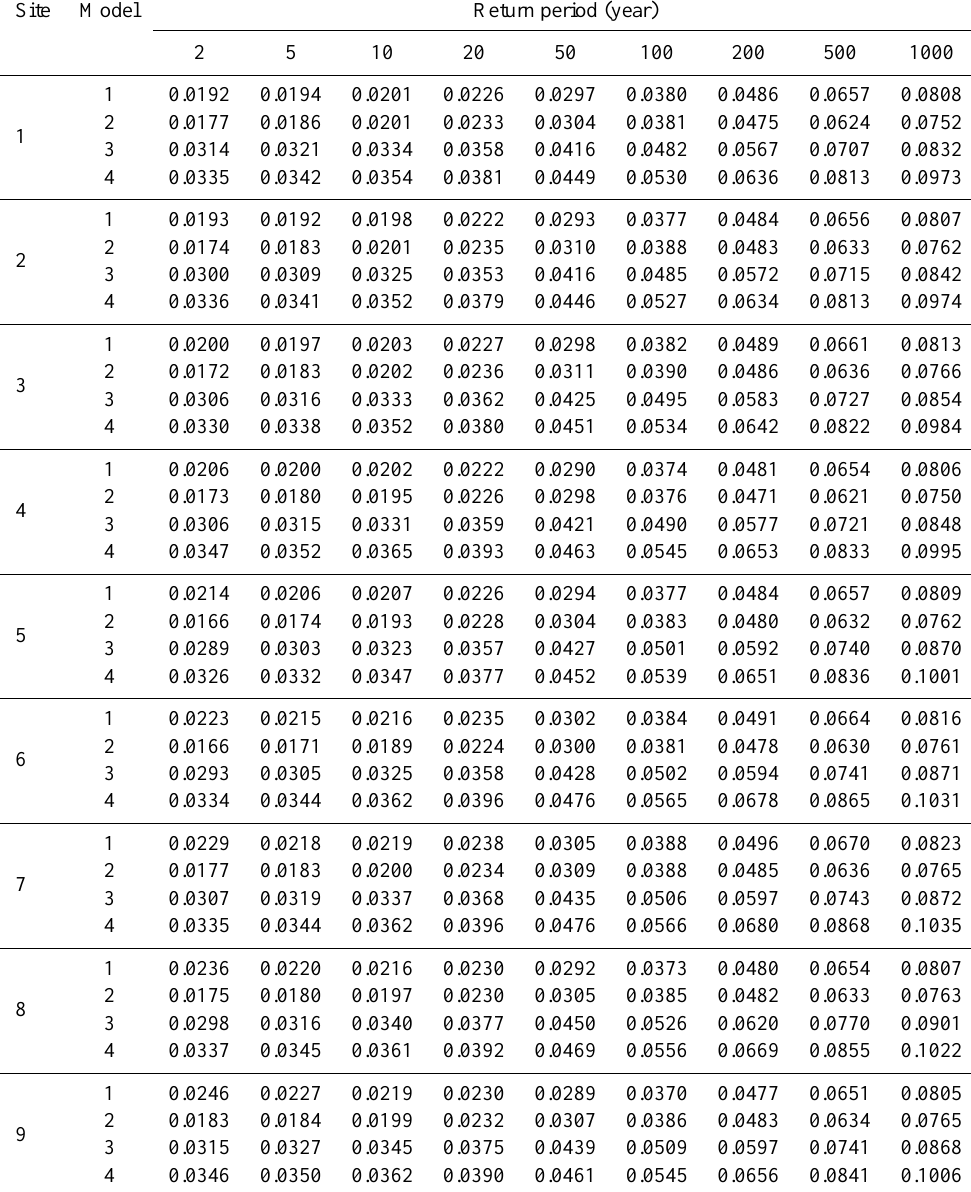
Table 2. RRMSE of 4 NSIFMs for a region with 9 sites (sample size =